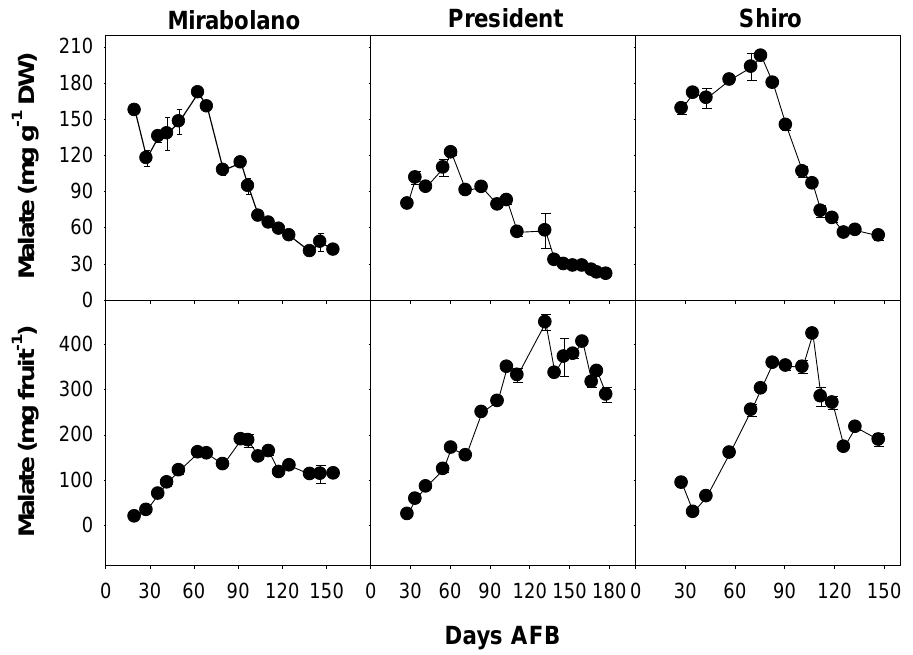
Figure 4. Malate contents of the flesh (mesocarp + epicarp) of fruits of Prunus cerasifera —Mirabolano, Prunus domestica —cultivar President, and Prunus salicina —cultivar Shiro at different stages of development. Each point on the graph shows the mean and standard error, n = 3. AFB = after full bloom.